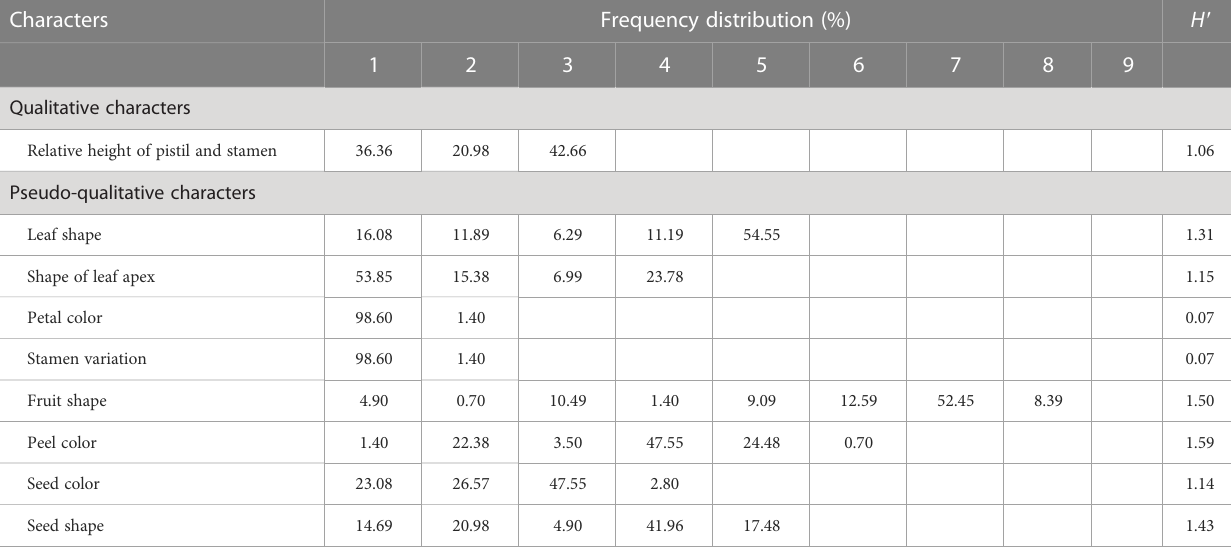
TABLE 1 Variability and genetic diversity of qualitative and pseudo-qualitative characters.